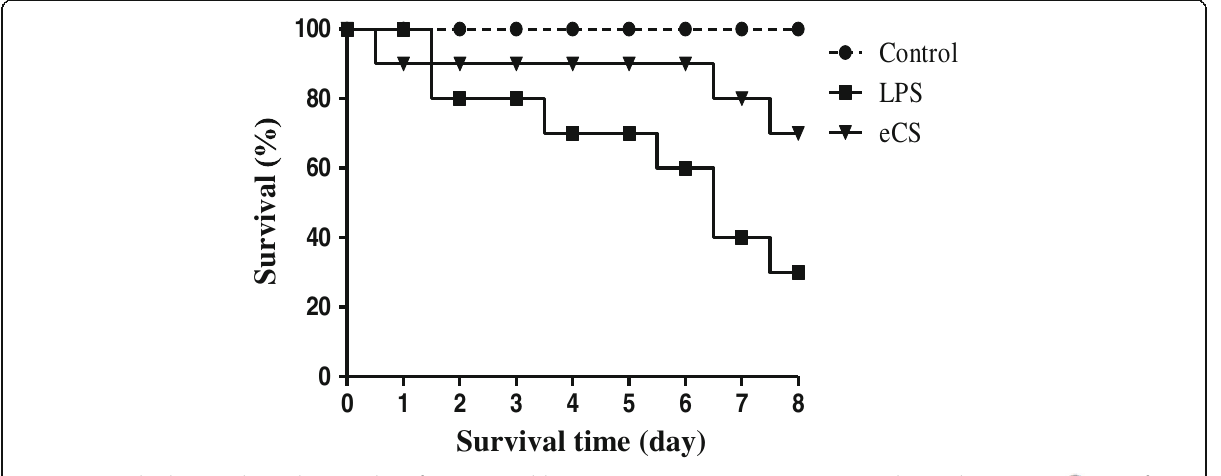
Fig. 8 Intratracheal eCS reduces the mortality of mice caused by sepsis. C57BL/6 ( n = 10/group) received a single i.p. PBS ( ) or of LPS/ D -(+)-galactosamine hydrochloride, without ( ) or with a single i.t. eCS (0.1 mg/kg body weight) 2 h later ( ). Morbidity and